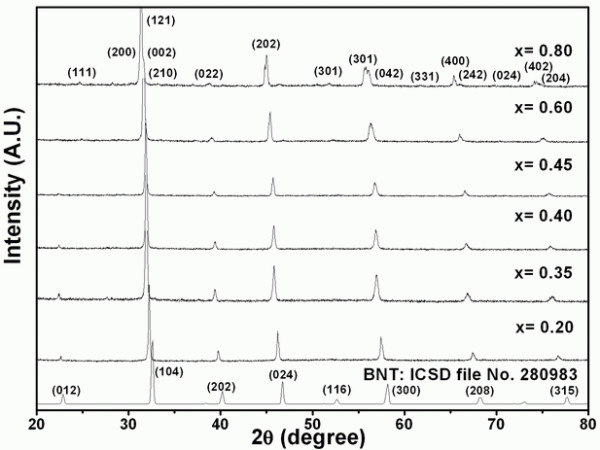
X-ray diffraction patterns of Bi0.5Na0.5Ti1-xZrxO3 ceramics. Where x = 0.20, 0.35, 0.40, 0.45, 0.60, and 0.80 mole fraction.